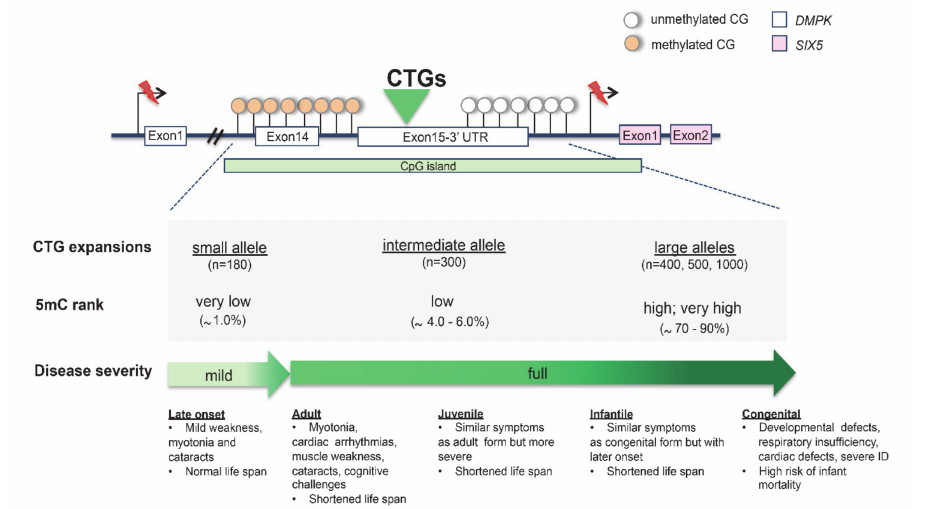
Figure 4. Hypermethylated CpG island in expanded CTG repeat of DMPK . The correlation between (CTG)n alleles, 5mC levels and clinical phenotypes is shown. The percentage of DNA methylation was analysed in DM1 human embryonic stem cells (hESCs)